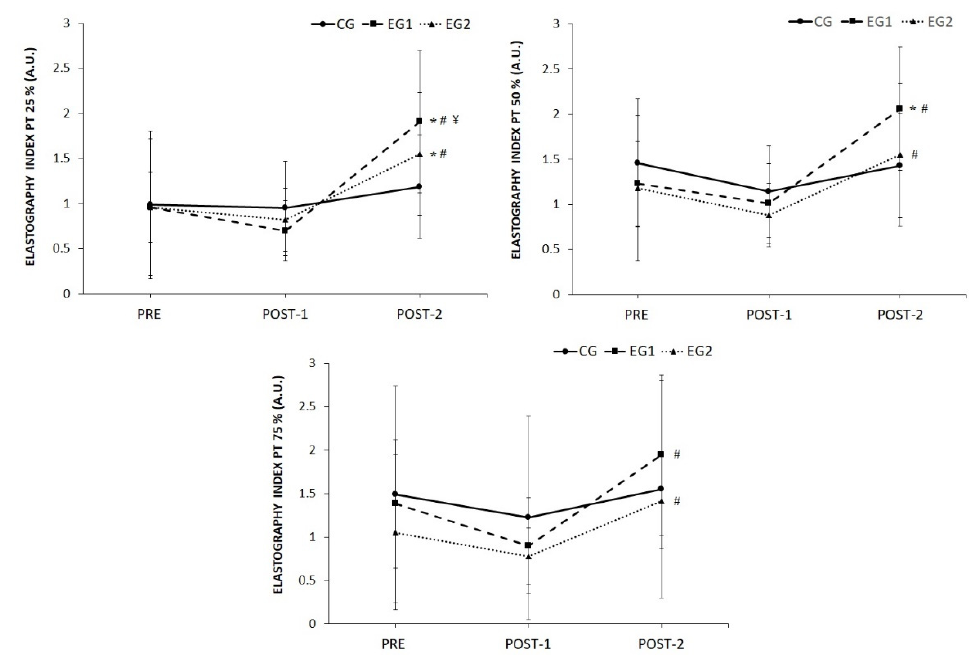
Figure 4. Elastic properties of the patellar tendon (PT) at 25%, 50% and 75% of the length of the PT after six weeks of eccentric training (POST-1) with two execution times (EG6s = 6 s and EG3s = 3 s) and after a 6 week follow-up of detraining (POST-2). ¥ = p < 0.05 from CG; # = p < 0.05 from POST-1 evaluation; * = p < 0.05 from pre-evaluation.